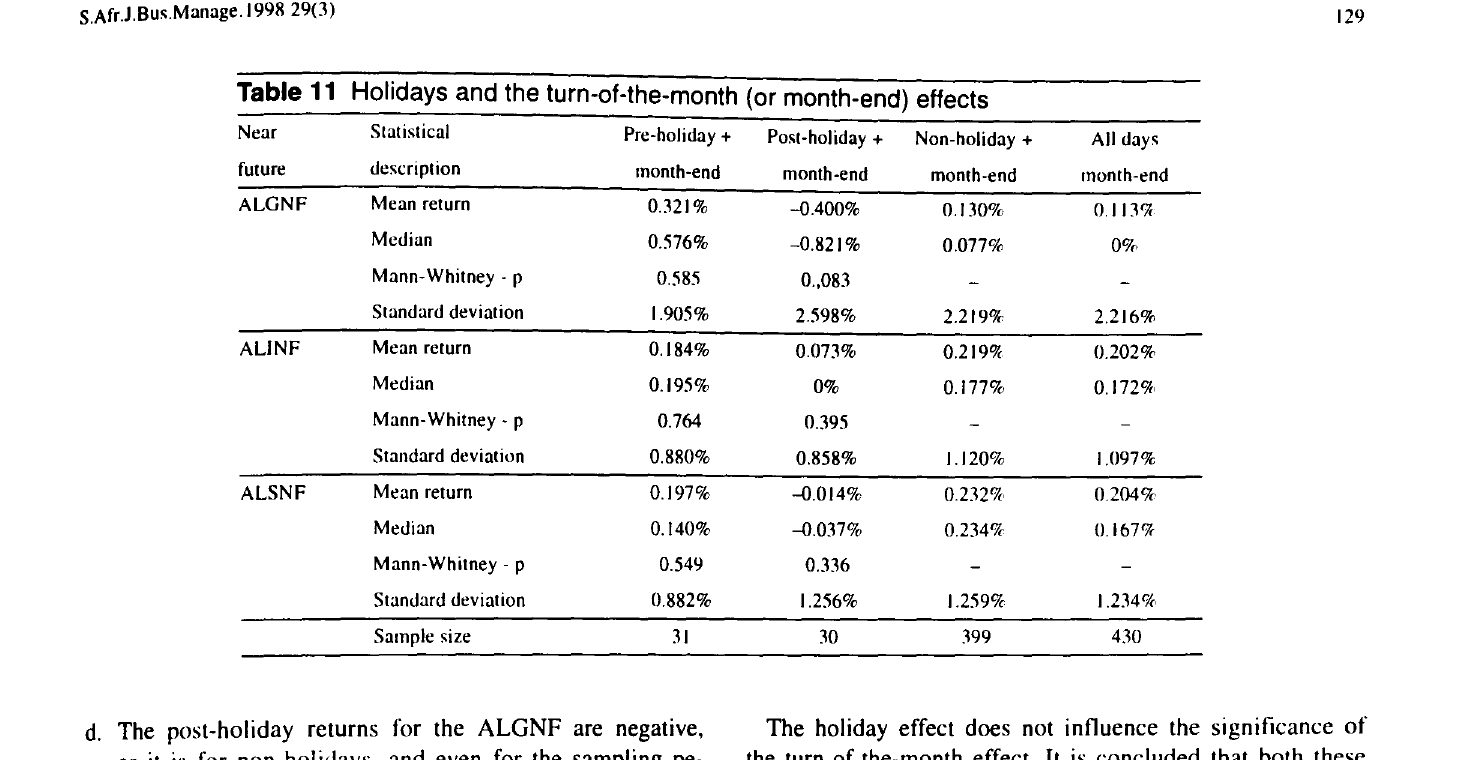
Table 11 Holidays and the turn-of-the-month (or month-end) effects